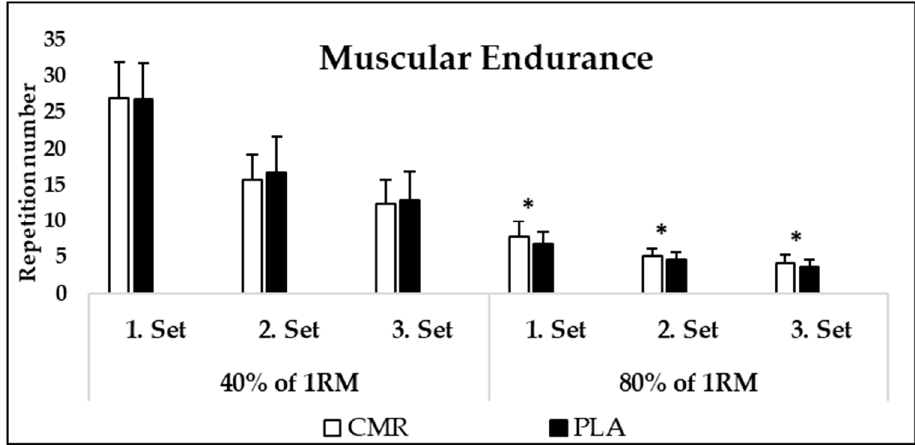
Figure 2. Mean (SD) bench press 40% or 80% of 1-RM repetitions to failure performance. CMR: carbohydrate mouth rinsing; PLA: placebo; *: Significantly different from PLA.